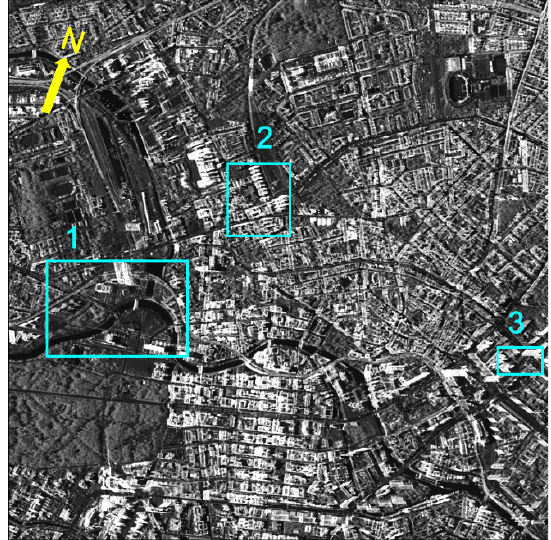
Figure 3. Mean TSX image over study area. Patches 1 to 3 are used for in-depth